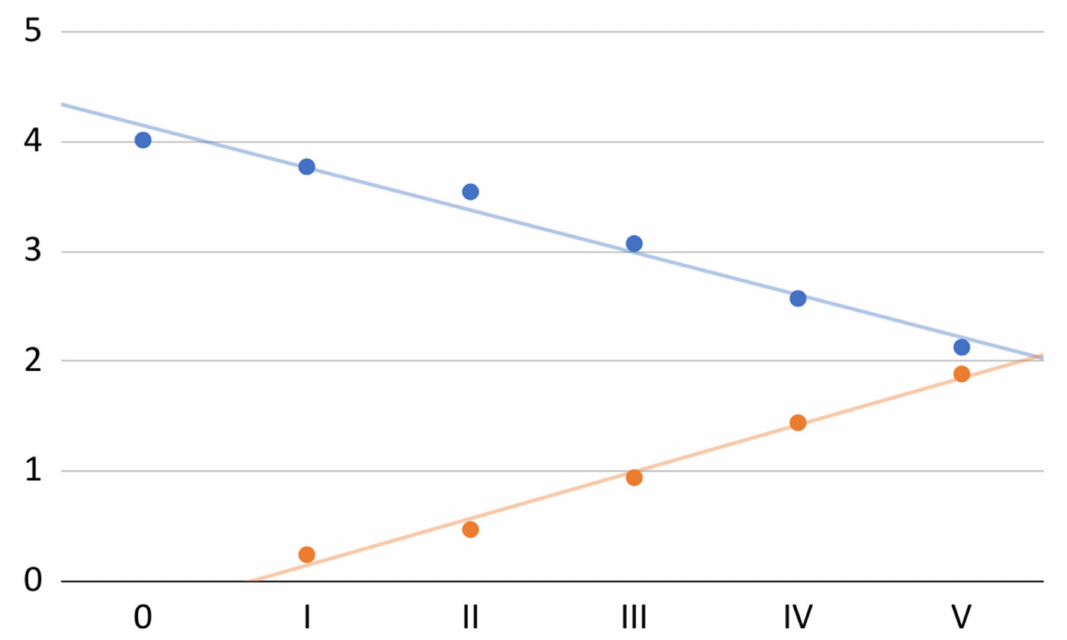
Figure 1. Mean spontaneous pain (blue) and mean effectiveness in pain relief (orange) on the VAS at individual